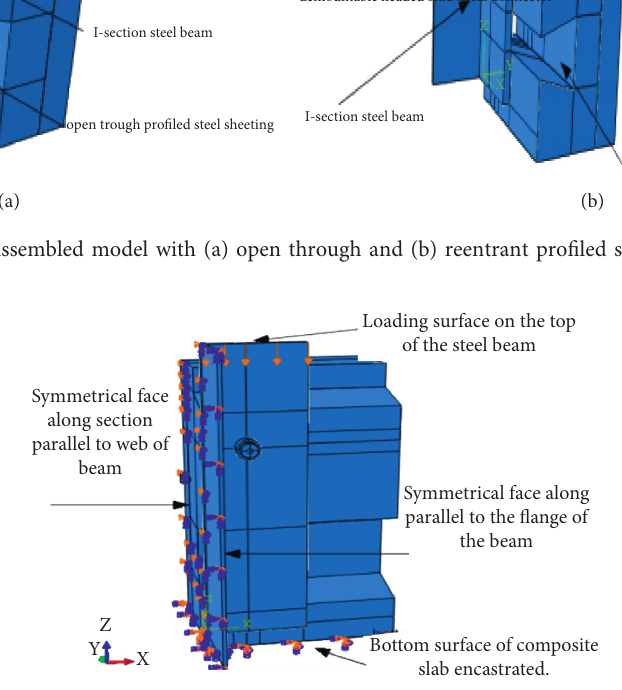
Figure 5: FE Model with boundary conditions, loading, and